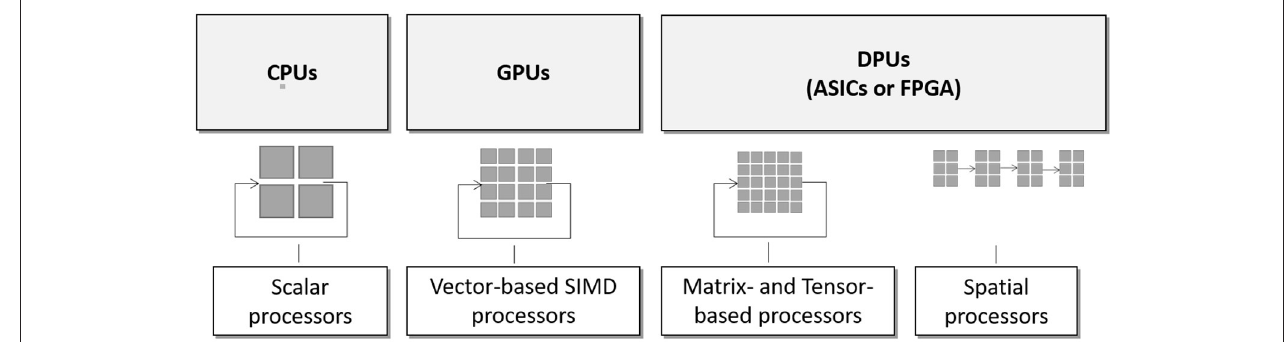
FIGURE 7 | Taxonomy of compute architectures, differentiating CPUs, GPUs and